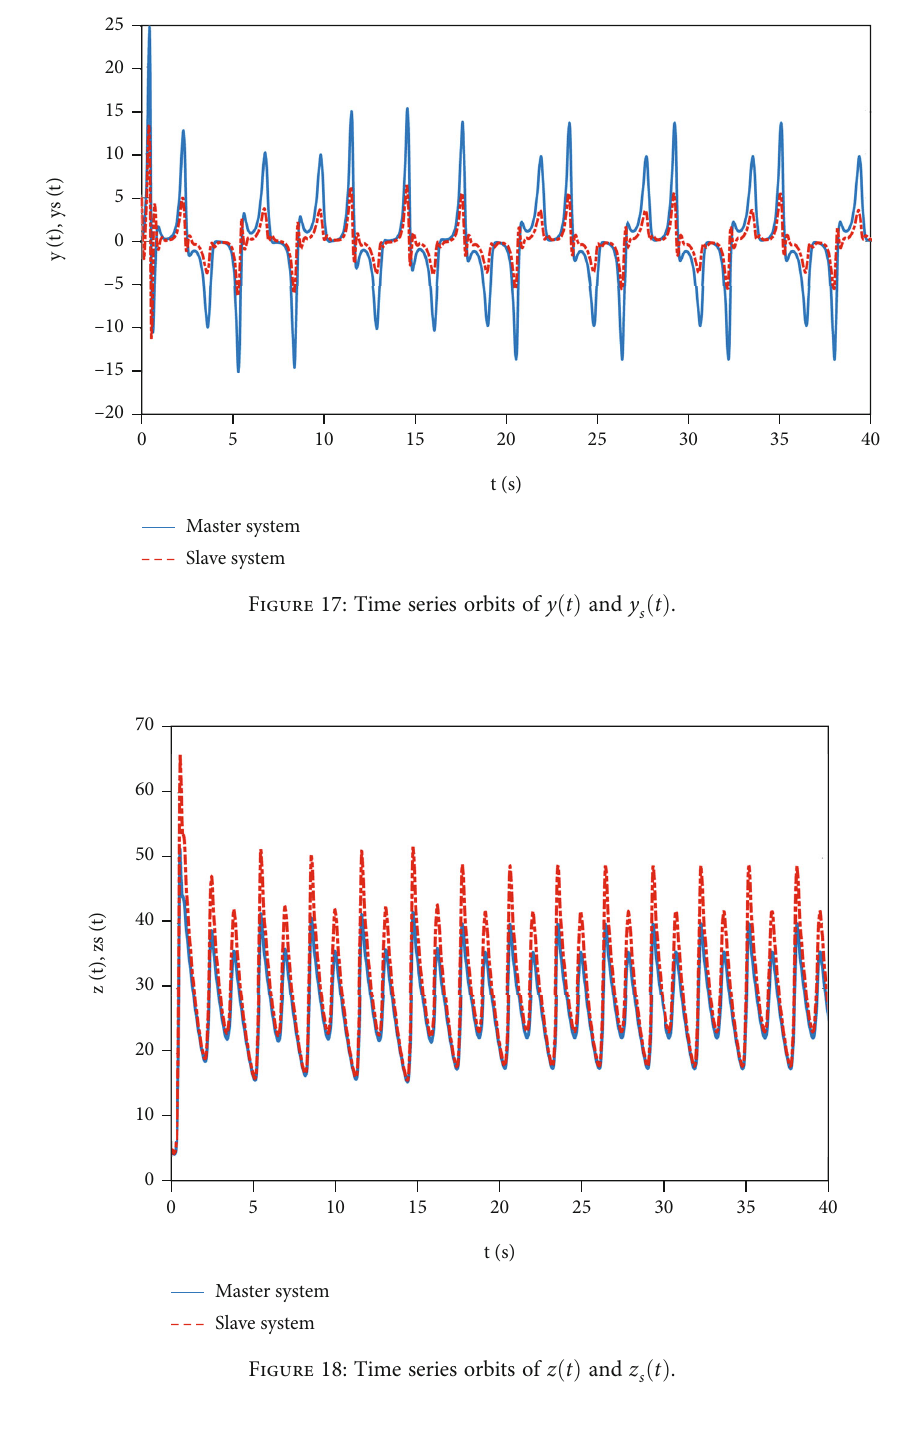
Figure 18: Time series orbits of z ð t Þ and z